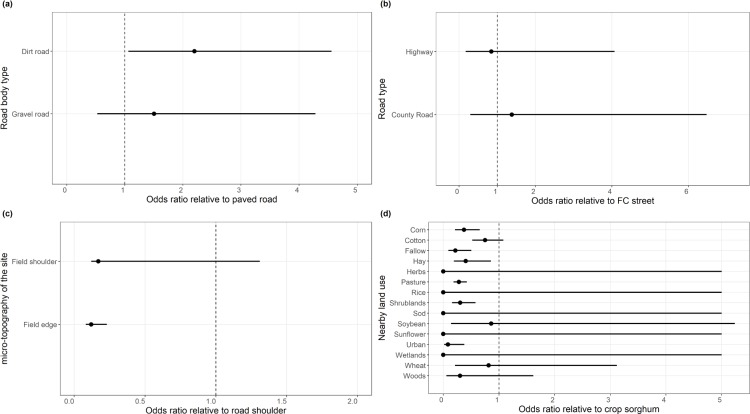
Odds ratio value (black dot) for the effects of road body-type (a), road type (b), micro-topography of the surveyed site (c) and nearby land use (d) on the presence of feral sorghum. The solid black line indicates the 95% confidence intervals for the odds ratio.